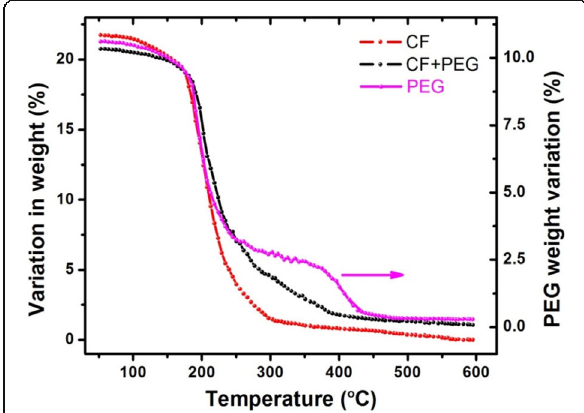
Fig. 5 Thermogravimetric analysis (TGA) of pure CoFe 2 O 4 , PEG, and PEG-coated CoFe